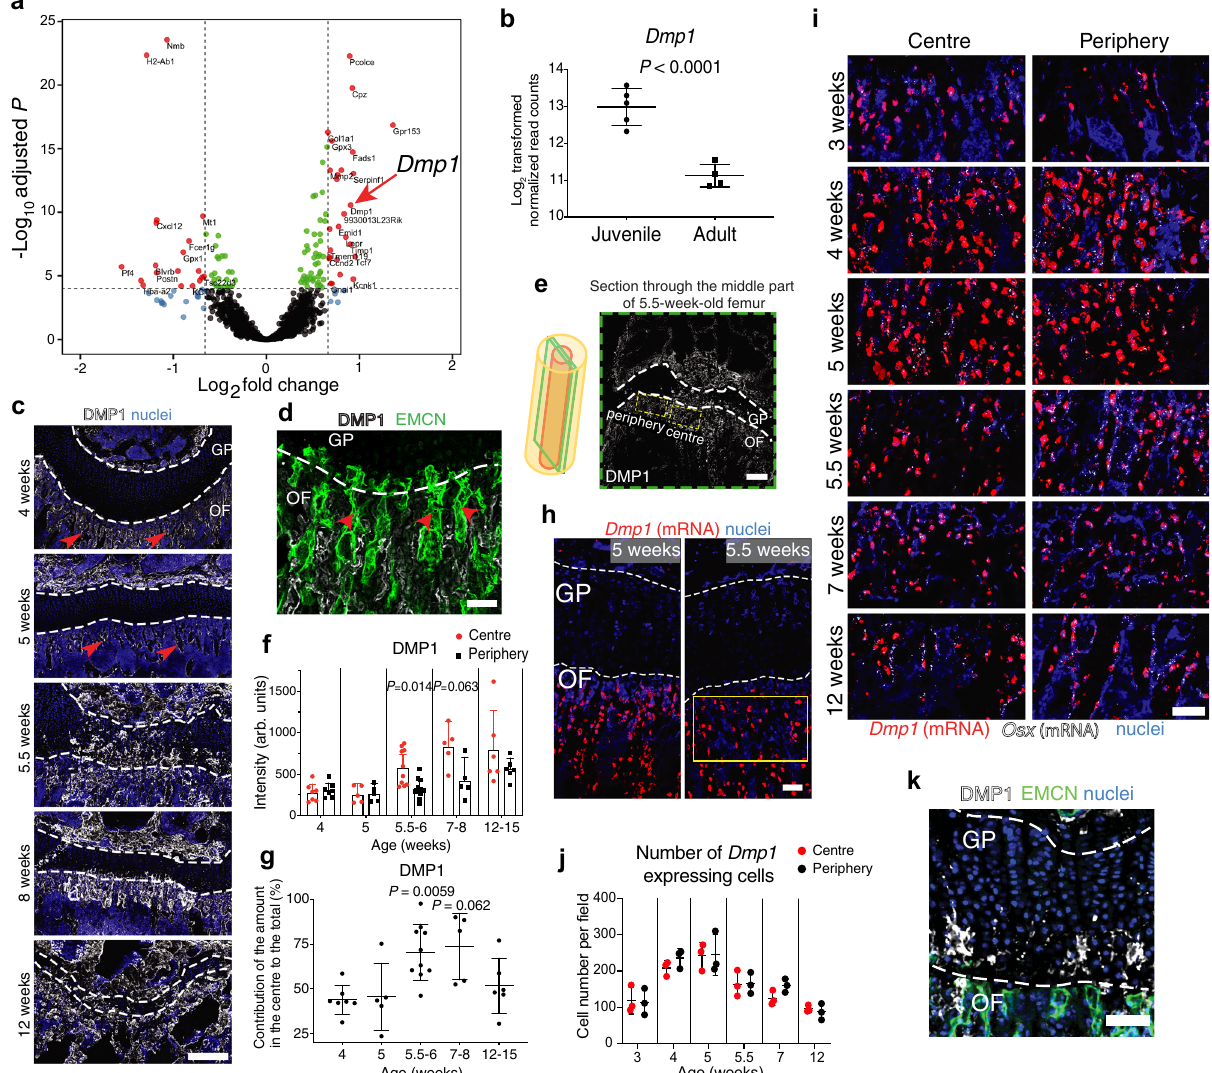
Fig. 1 Burst in DMP1 secretion from osteoblasts into ECM at the OF-GP border during periadolescence. a Volcano plot of signi fi cantly differentially expressed genes in juvenile (4 weeks, n = 5) versus adult (12 weeks, n = 4) capillary with surrounding cells from the ossi fi cation front (OF) (mean expression value >500, red: Log 2 FC > 0.66, P < 10 − 5 ). b , Log 2 transformed number of reads mapped to the Dmp1 gene. c DMP1 immunostaining in the OF throughout postnatal bone development. Red arrows point at DMP1 at the OF base. Scale bar 250 µ m. d DMP1 and endomucin (EMCN) immunostaining of the OF from 5-week-old femur. Red arrows point at type H vessels. Scale bar 50 µ m. e Schematic depiction of the femur with a green plane going through the centre of the bone, where DMP1 secretion is observed. Example of DMP1 immunostaining of a section taken from the middle part of the femur, showing the de fi nition of the central and peripheral regions used for further automated quanti fi cation. Scale bar 250 µ m. f Quanti fi cation of DMP1 staining intensity in the centre and periphery of the OF throughout bone development. Mean ± SD. g Quanti fi cation of the contribution of the central and peripheral part to the total DMP1 amount. Mean± SD. f , g at 4 weeks n = 7, 5 weeks n = 5, 5.5 – 6 weeks n = 10, 8 weeks n = 5, 12 – 15 weeks n = 6. Pooled data from fi ve independent experiments. P values show the signi fi cance between the intensity in the centre versus periphery for every mouse (paired analysis). Two- tailed Wilcoxon matched-pairs signed-rank test. h Dmp1 mRNA (RNAScope) of the central regions of OF and GP from 5- and 5.5-week-old femurs. Lack of Dmp1 expression in chondrocytes of the GP; yellow frame indicates the region shown in i . Scale bar 50 µ m. i RNAScope images of Dmp1 , Osterix ( Osx ), and Runx2 (only depicted in Supplementary Fig. 2c). Scale bar 50 µ m. j Number of Dmp1 -expressing cells in the central and peripheral region of the OF based on RNAScope images. n = 3 per age. Pooled data from two independent experiments. Mean± SD. k DMP1 and EMCN immunostaining of 5.5-week-old femur. In fi ltration of DMP1 from the OF into the GP. Scale bar 50 µ m. b , f , g , j Source data are provided in Source Data fi le. (Supplementary Fig. 4g – i). Deletion of Dmp1 was performed at (Supplementary Fig. 6d). Yet, long bones of Dmp1 i Δ OB mice P28-32 to allow normal formation of the OF together with the featured an enlarged metaphysis with overall increased EMCN columnar structure of blood vessels (Fig. 2c). Tamoxifen and MMP9 intensities (Fig. 2e, f and Supplementary Fig. 6e). In treatment led to ~75% reduction of Dmp1 mRNA expression line with the femur phenotype of constitutive Dmp1 -de fi cient by week 6 (P42) (Supplementary Fig. 6a, b) and reduced the mice (cf. Supplementary Fig. 4d, f), also Dmp1 i Δ OB femurs were amount of DMP1 protein in the OF centre by ~70% (Fig. 2d and slightly shorter than control femurs by the age of 6 weeks, Supplementary Fig. 6c). The body weight was not affected presumably re fl ecting the key role of DMP1 in matrix NATURE COMMUNICATIONS| (2022) 13:3059